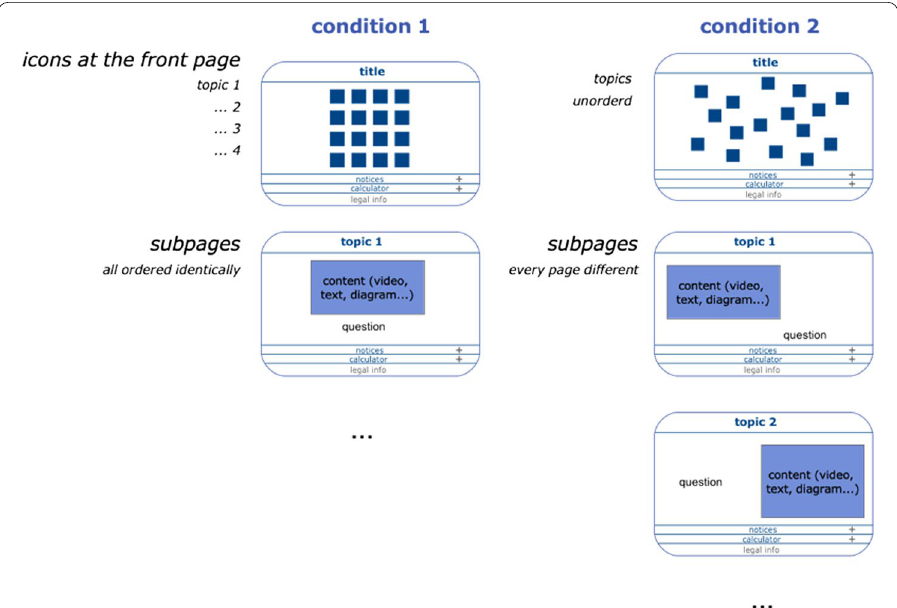
Fig. 3 Schematic visualization highlighting the design differences between experimental